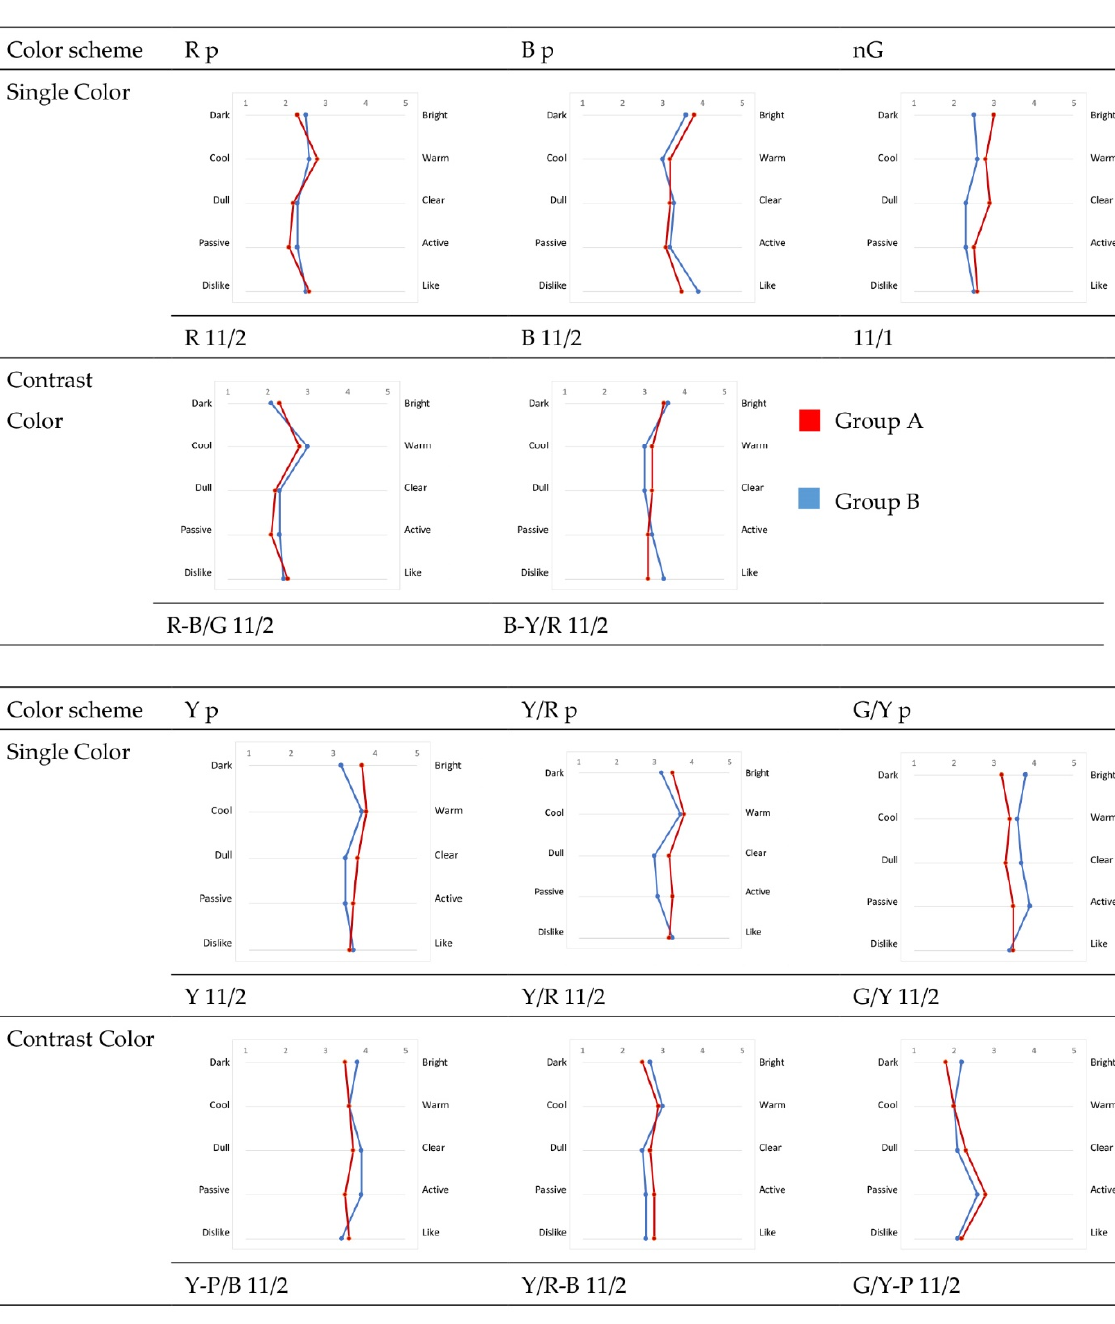
Figure 7. Psychological response to interior space colors based on 1–5 Likert scale.